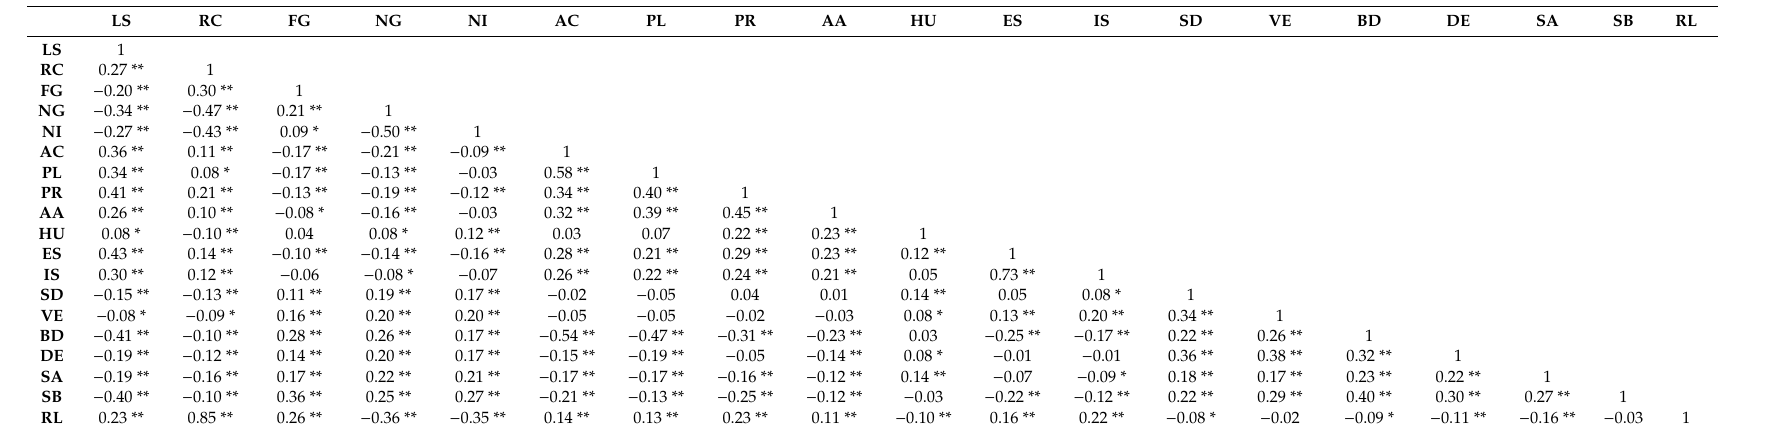
Table 2. Correlation matrix between dimensions of religious struggle, life satisfaction, and coping strategies (N =